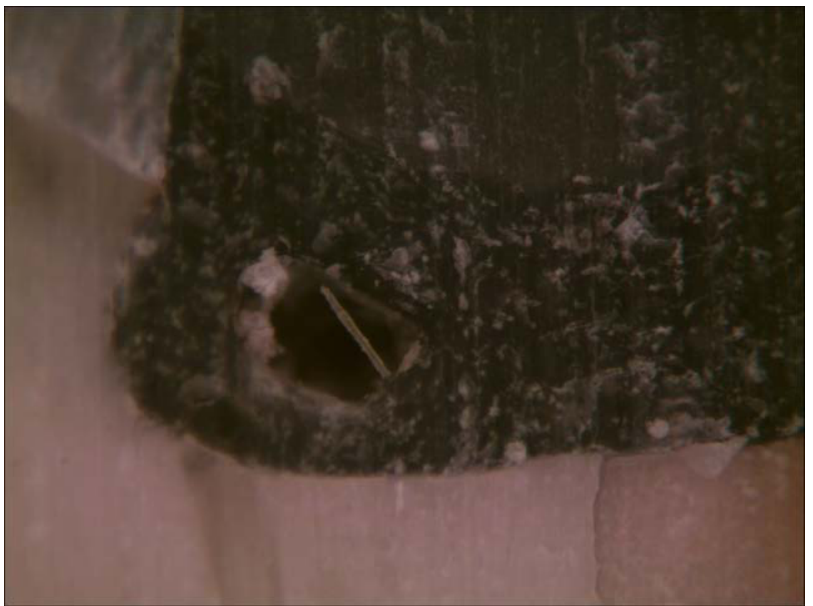
Figure 5. Internal air-bubble formation within the cured SFRC material.